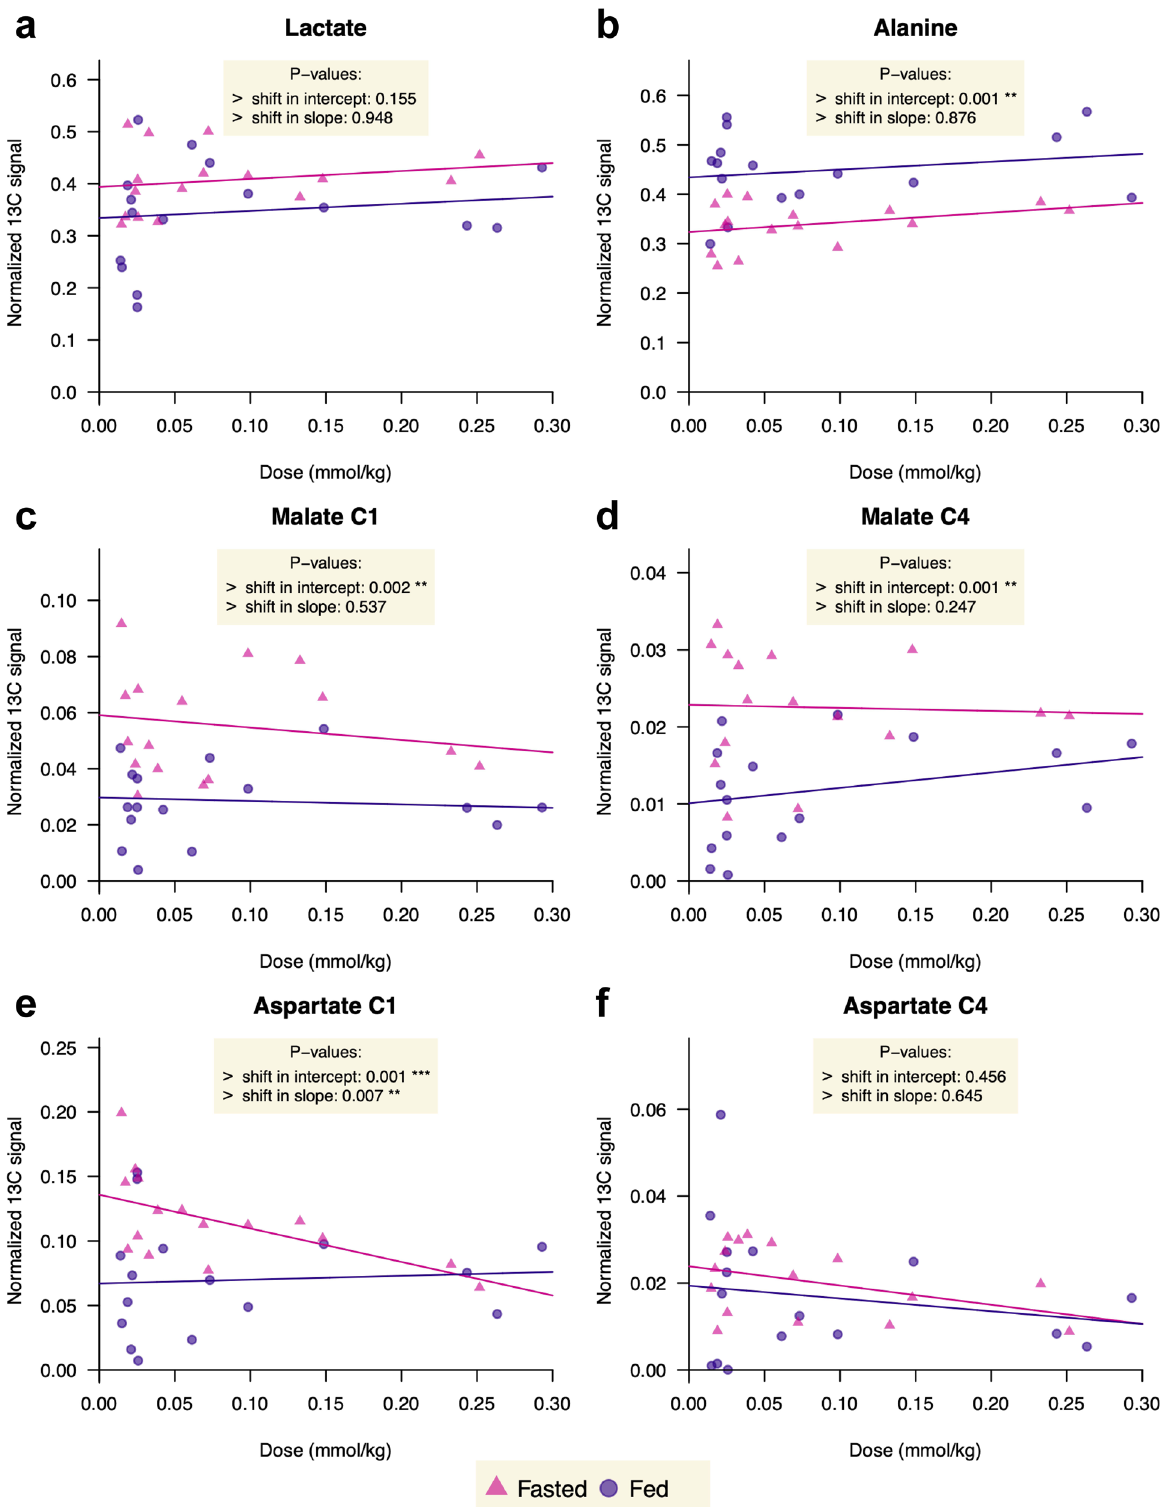
Fig. 3 Scatter-plot of the 13 C-metabolites signal intensities normalized to the total sum of metabolites as a function of the injected dose of HP [1- 13 C] pyruvate. a HP [1- 13 C]lactate, ( b ) HP [1- 13 C]alanine, ( c ) HP [1- 13 C]malate, ( d ) HP [4- 13 C]malate, ( e ) HP [1- 13 C]aspartate, and ( f ) HP [4- 13 C]aspartate. Points for 32 experiments (16 fed; 16 fasted) are coded by nutritional state (purple circles: fed; pink triangles: fasted). The fi tted regressionabb line of a heteroscedastic linear model is shown for each state. The p -values correspond to the two-sided Wald t-tests of equality of intercept and slopes.